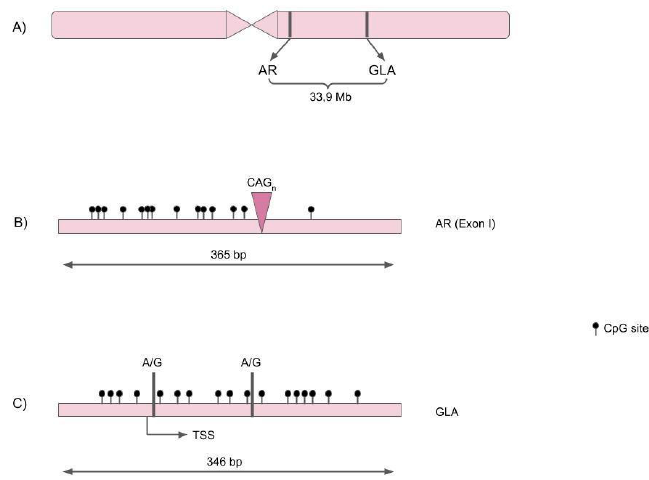
Figure 1. ( A ) Androgen Receptor ( AR ) and α -galactosidase ( GLA ) gene position on the X chromosome. Figure 1. (A) Androgen Receptor ( AR ) and α -galactosidase ( GLA ) gene position on the X ( B ) Structure of the AR amplicon (365 bps; hg19 genomic coordinates: 66764978-66765342, strand + ). chromosome. (B) Structure of the AR amplicon (365 bps; hg19 genomic coordinates: The position of the trinucleotide repeat (CAG) is indicated. ( C ) Structure of the GLA amplicon (346 bps; 66764978-66765342, strand+). The position of the trinucleotide repeat (CAG) is indicated. (C) hg19 genomic coordinates: 100662748-100663093, strand-). The position of the single nucleotide Structure of the GLA amplicon (346 bps; hg19 genomic coordinates: 100662748-100663093, strand-). polymorphisms (A / G) and of the transcription start site (TSS) is